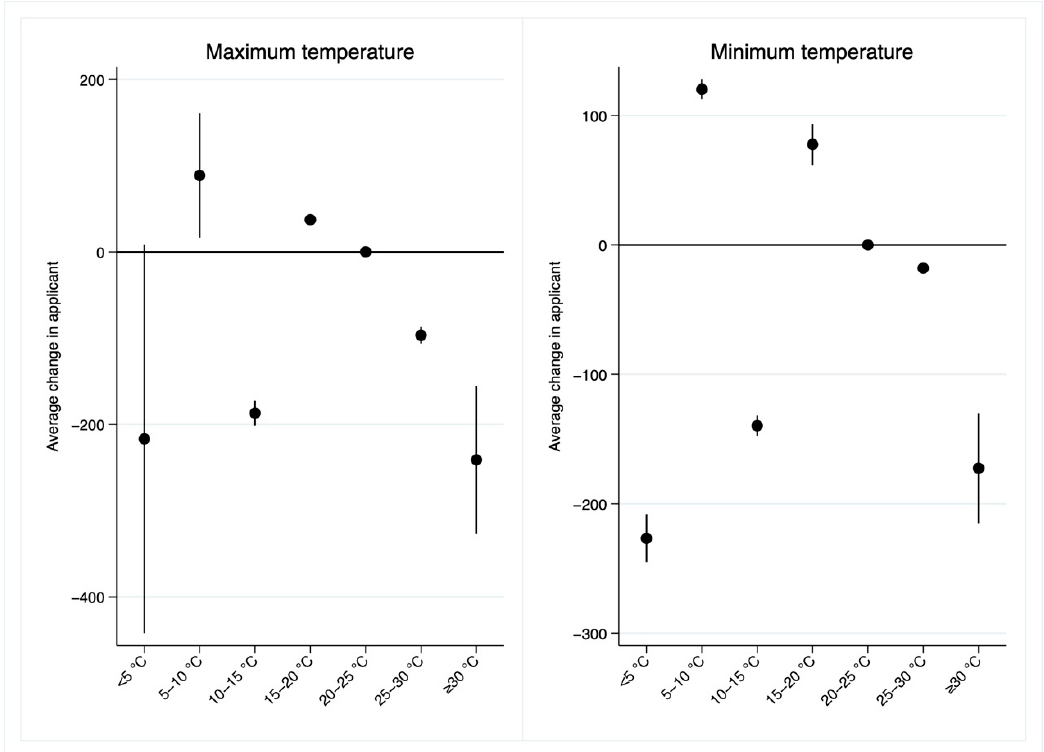
Figure 7. Estimated impacts of average temperature on the number of applicants for the UNGEE using alternative temperature measures.